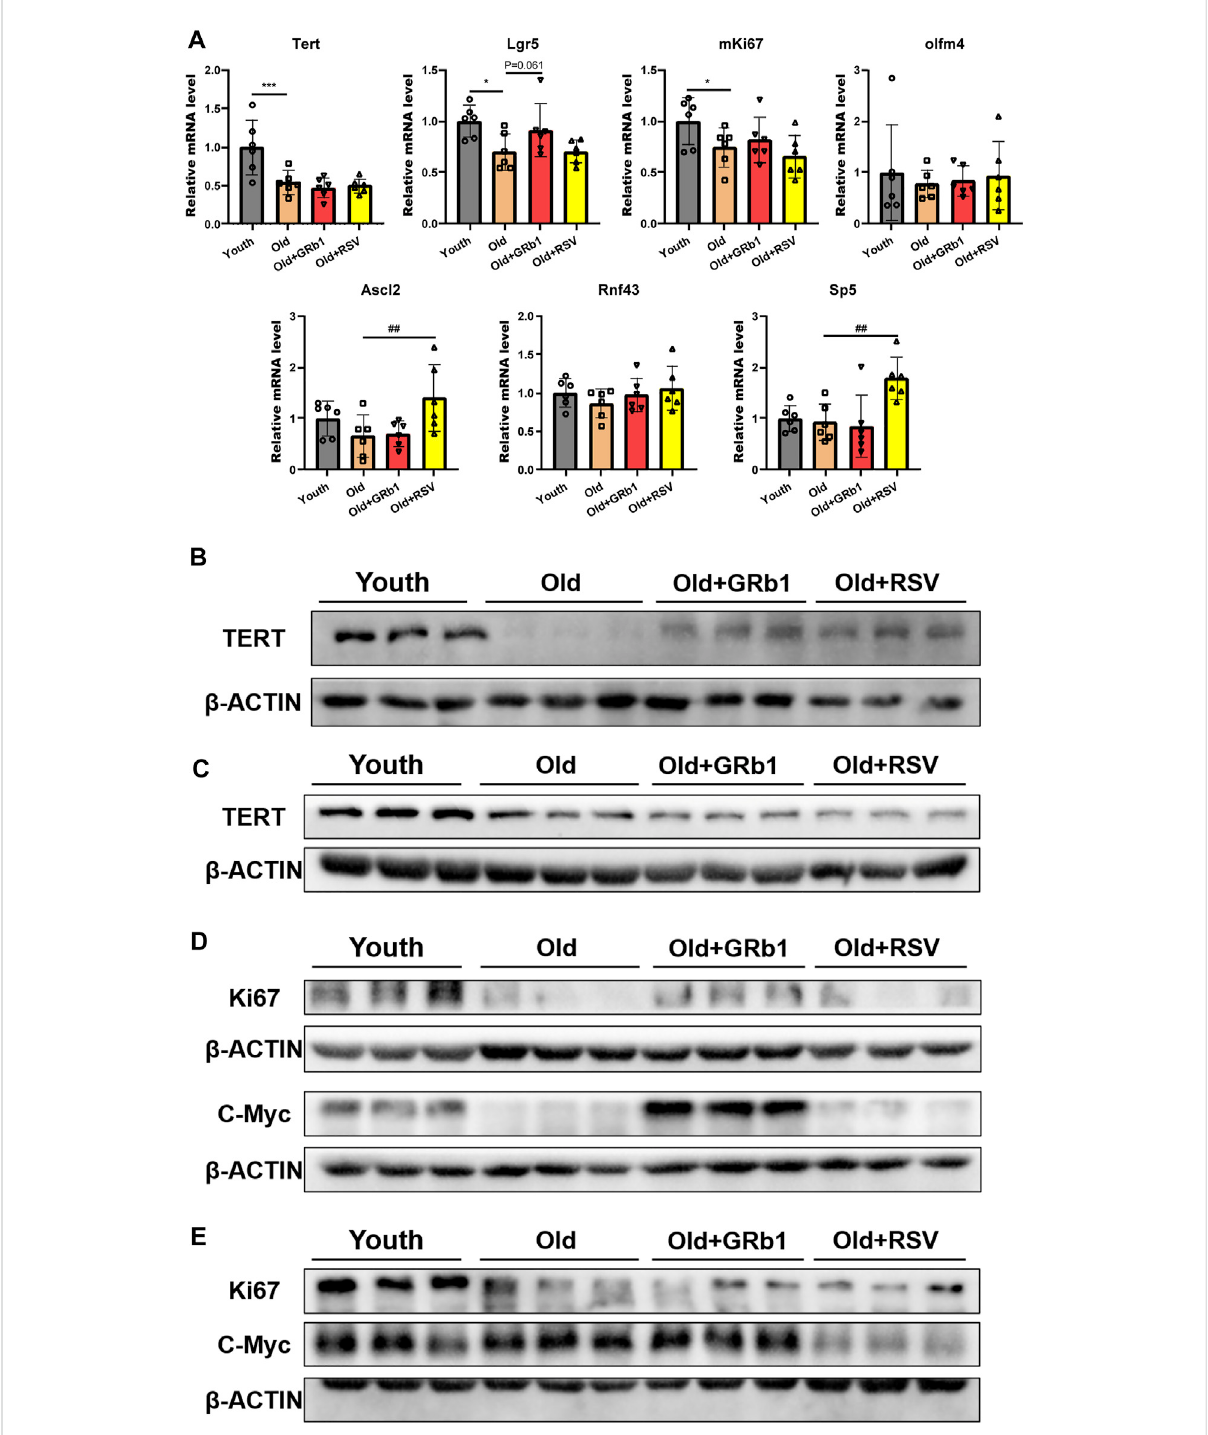
FIGURE 3 GRb1 was effective to improve the function ofintestinal stem cells ofold mice. (A) Relative mRNA expressionlevels of Tert , Lgr5 , mKi67 , Olfm4 , Ascl2 , Rnf43 ,and Sp5 inthesmallintestines. (B,C) ImagesofwesternblotbandsofTERTinthe (B) jejunumand (C) colon. (D,E) Westernblotresultsof Ki67 and c-Myc from the (D) jejunum and (E) colon. * p < 0.05, *** p < 0.001, compared with the Youth group; ## p < 0.01, compared with the Old